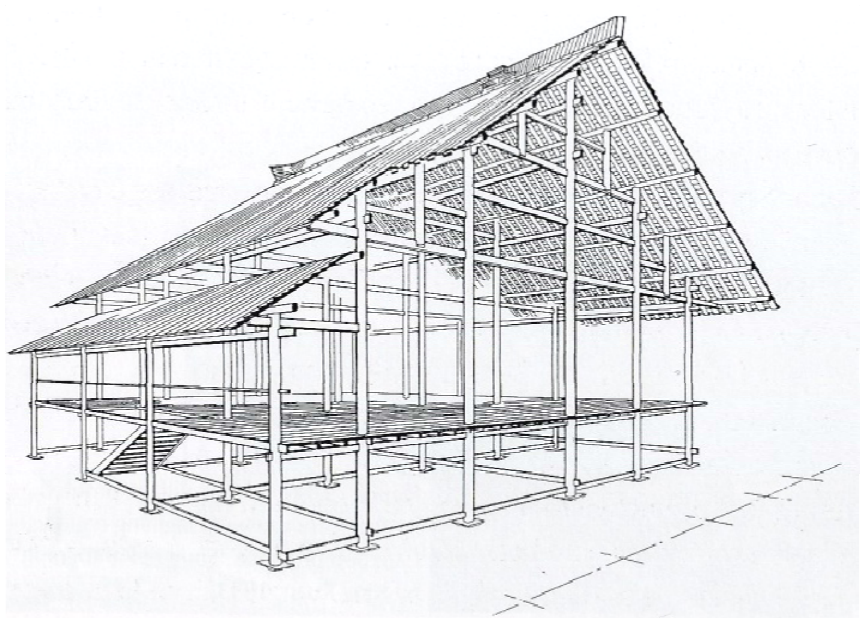
Figure 23. Wooden storied structure [17].